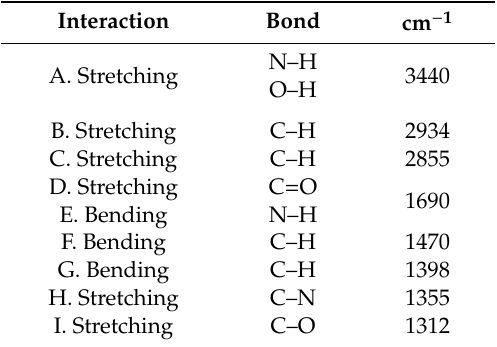
Figure 12. ( a ) IR spectra and ( b ) UV-Vis spectra of P1 .